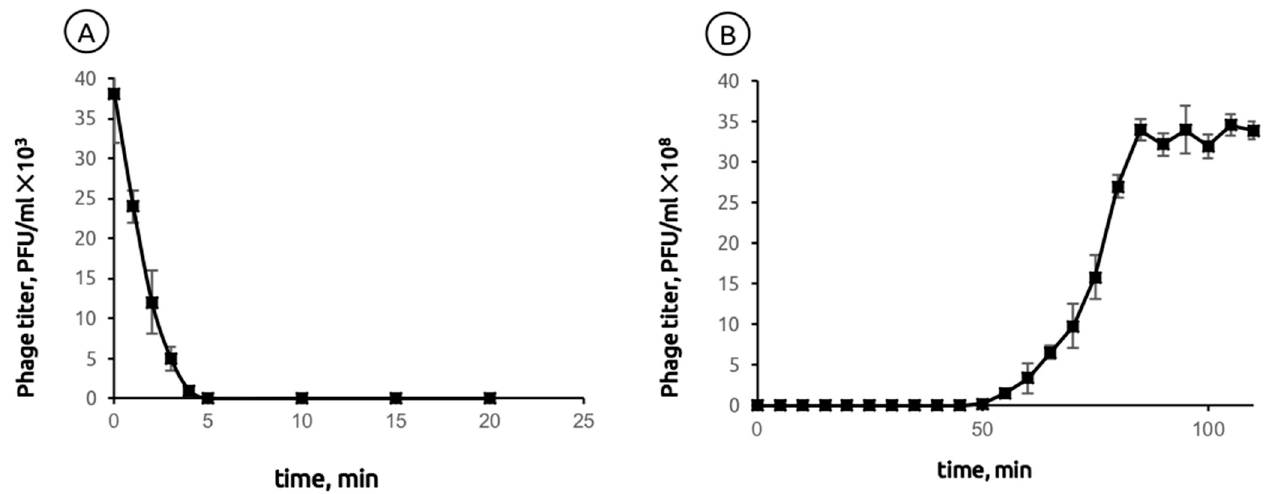
Figure 1. ( A ) Adsorption of phage MD8 to P. aeruginosa PAO1. The Y-axis represents the concentration of a non-adsorbed phage in the solution ( B ) Latent period and burst size of phage MD8 on the same host.